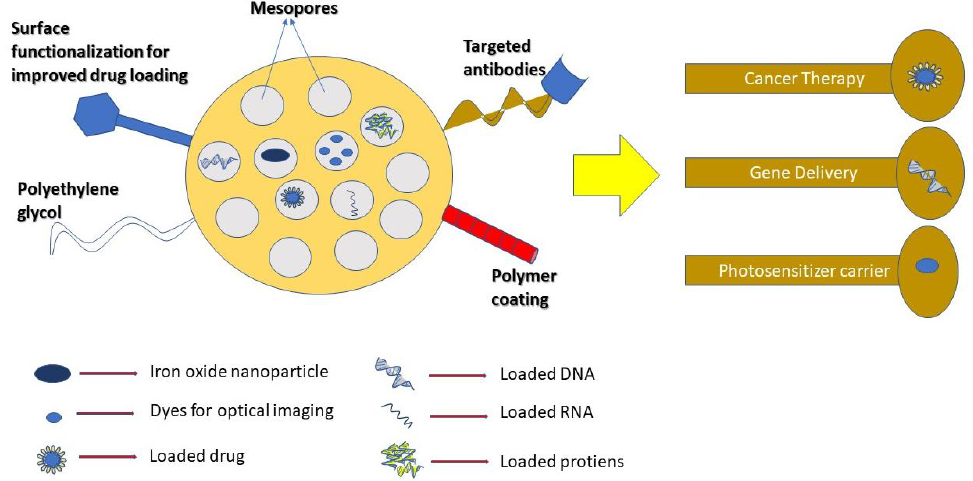
Figure 8. Diagram representing the various applications of MSN in medicine.